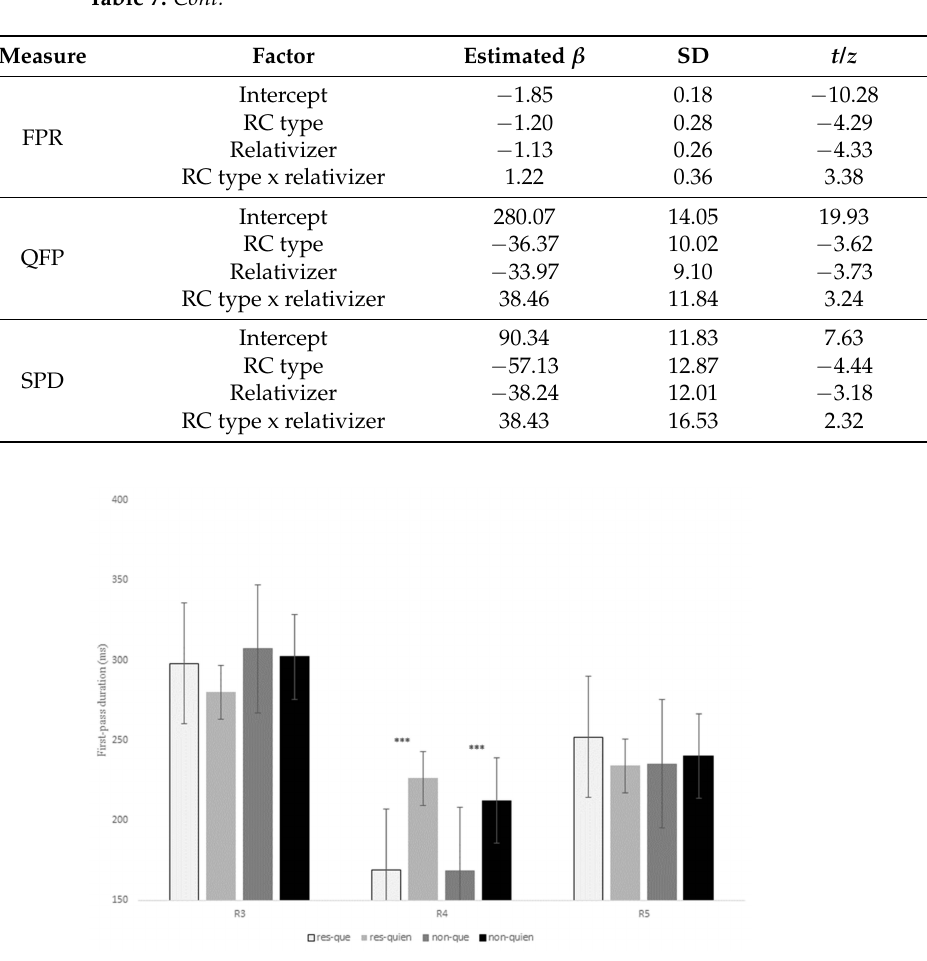
Figure 5. Reading time in milliseconds for first-fixation duration at regions 3, 4, and 5 for the contrast que versus quien in restrictive and non-restrictive RCs. Asterisks indicate that an effect is significant at p < 0.001.